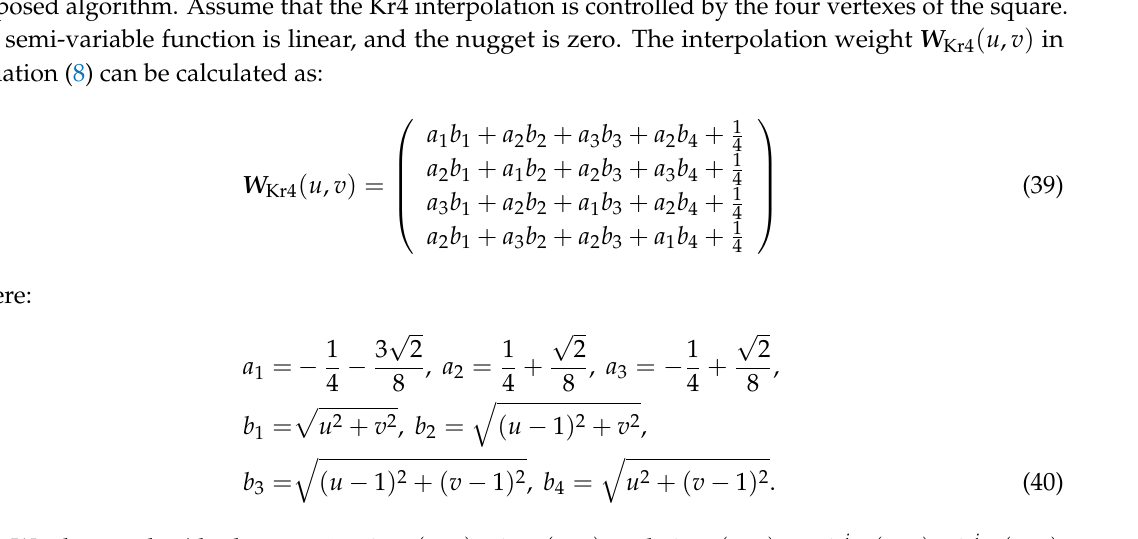
Figure 9. Function images of W 1